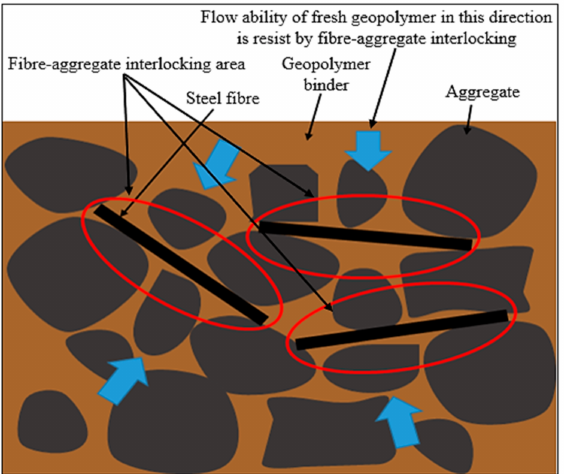
Figure 3. Flow of fresh reinforced geopolymer concrete is resisted by fiber-aggregate